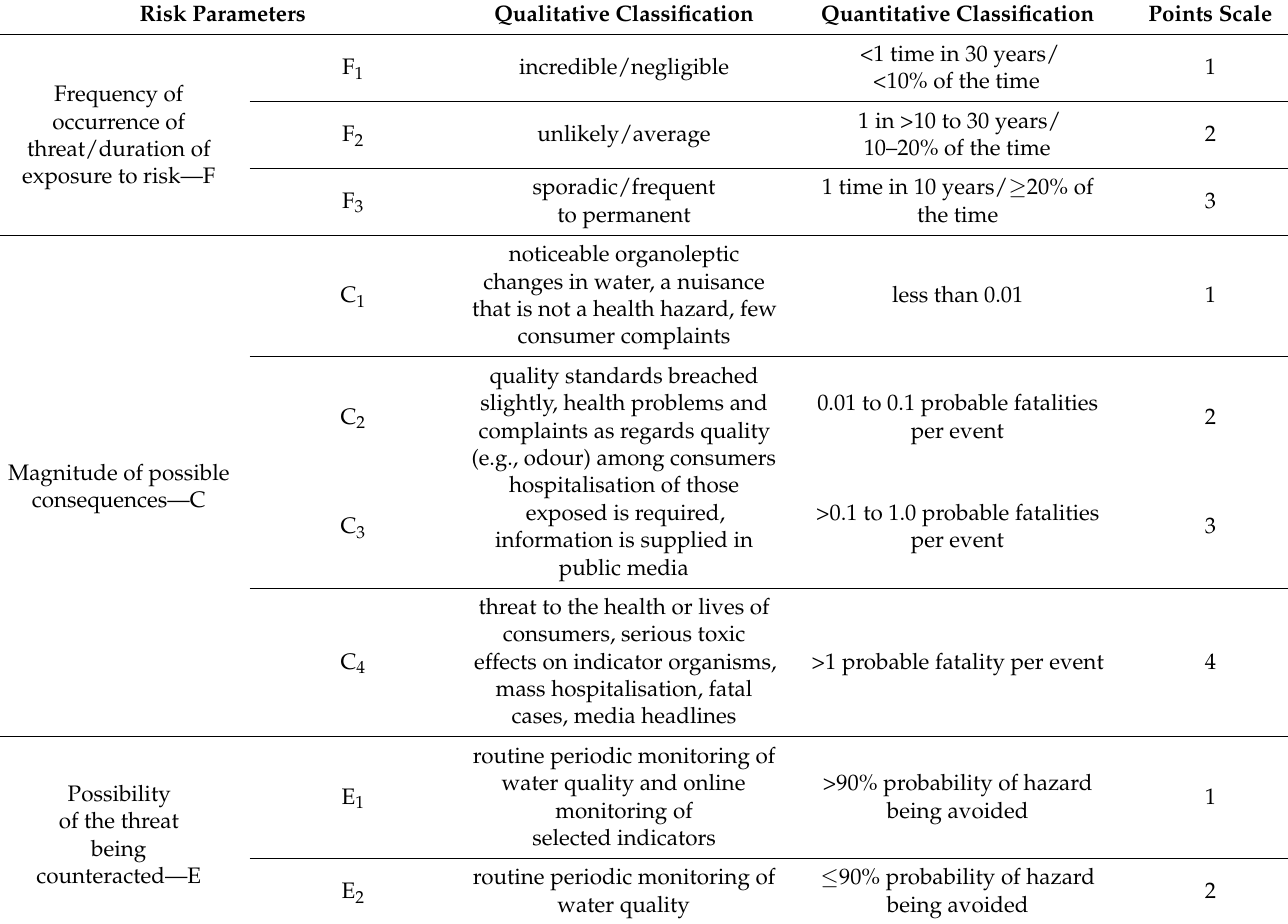
Table 1. Classification of risk parameters.